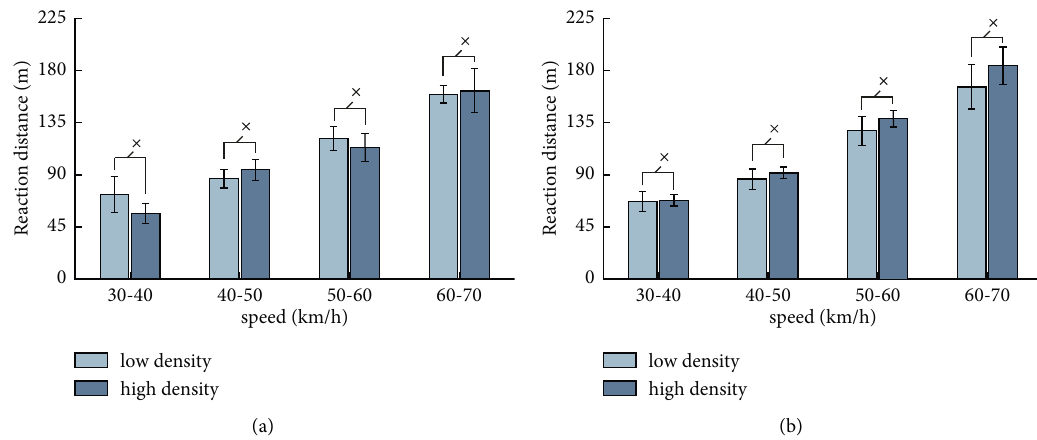
Figure 13: AVOVA results for traffic density on the first reaction distance. (a) Freedom; (b) follow.